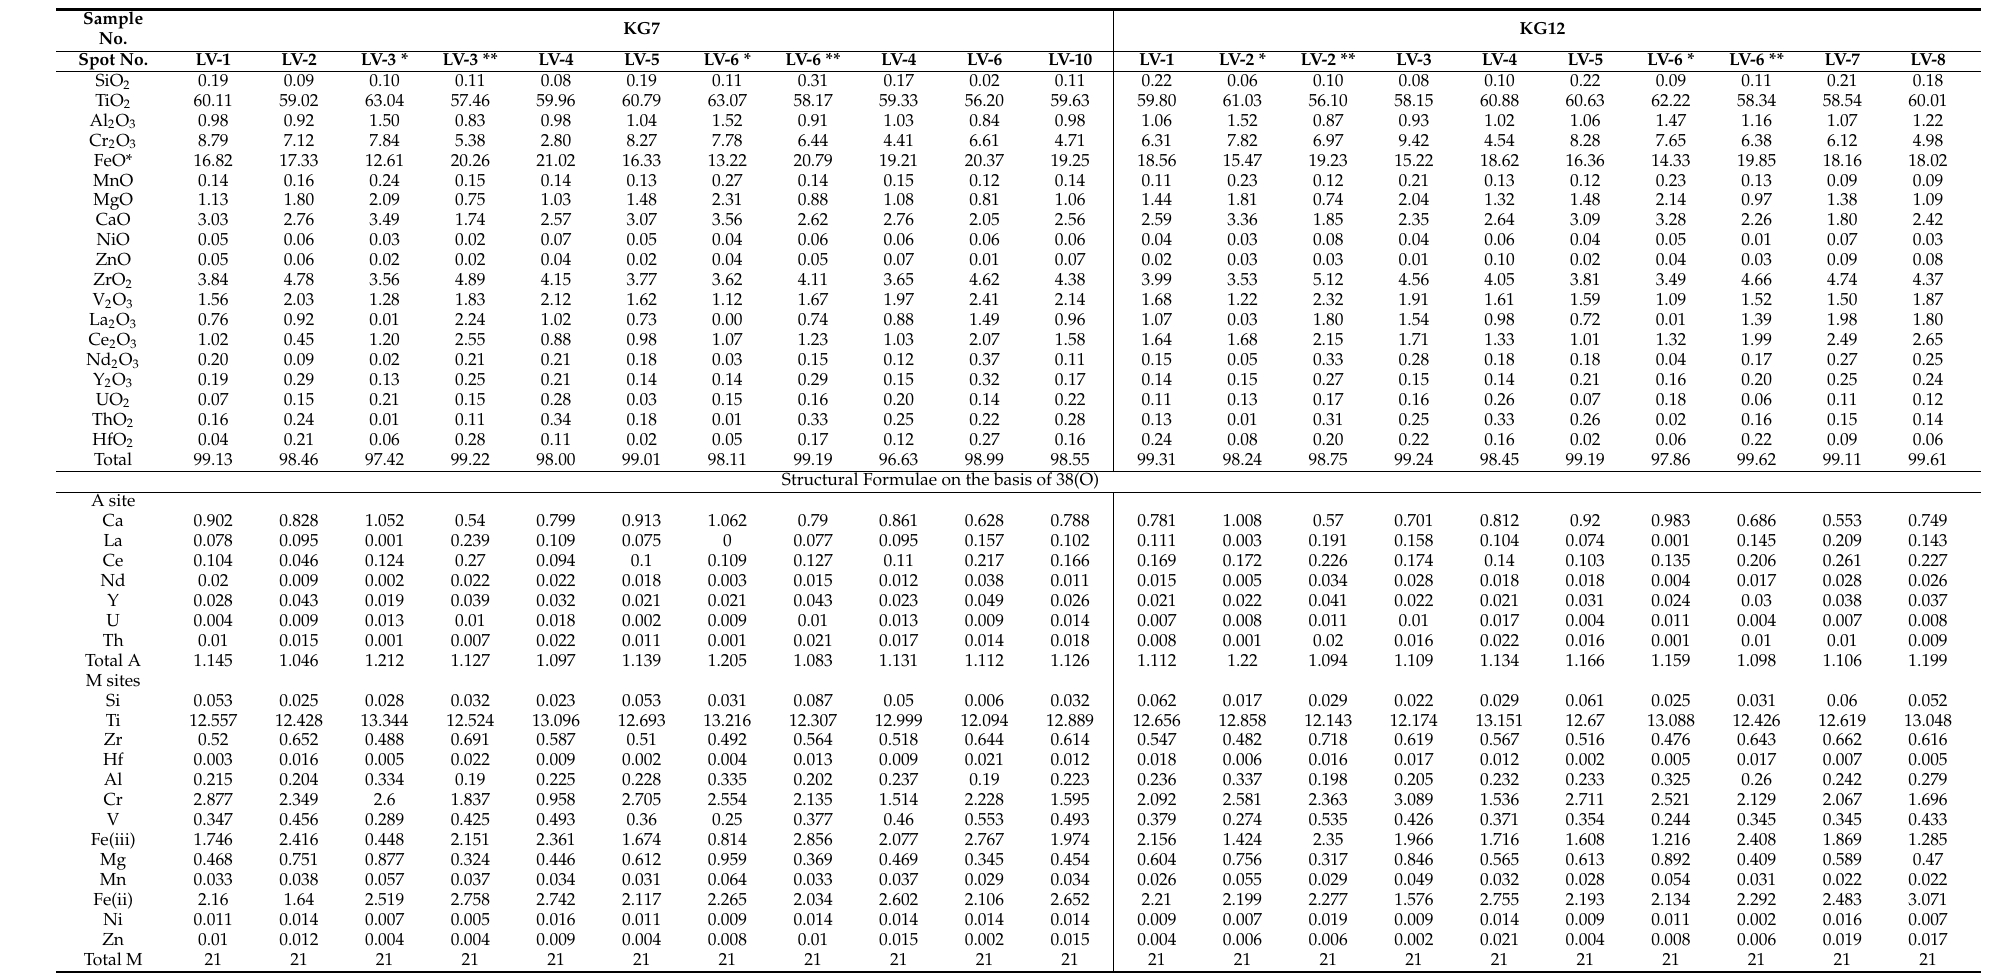
Table 6. Microprobe analyses of loveringite in the olivine gabbro of the Khamal mafic intrusion. Sample No. KG7 KG12 Spot